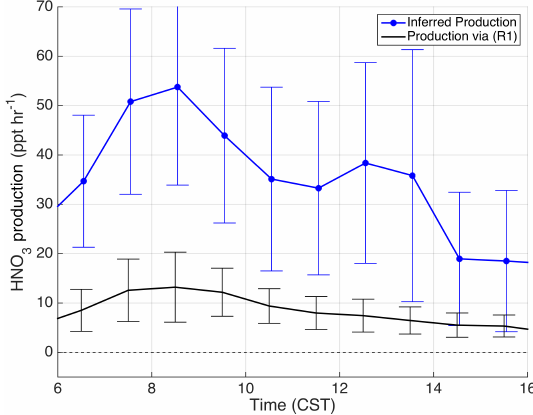
Figure 4. Production rates of nitric acid during SOAS calculated from the reaction of OH + NO 2 (black) and inferred from the con- centration and deposition rate of nitric acid (blue). The vertical bars show the systematic and random uncertainty in the calculated rates, as described in the